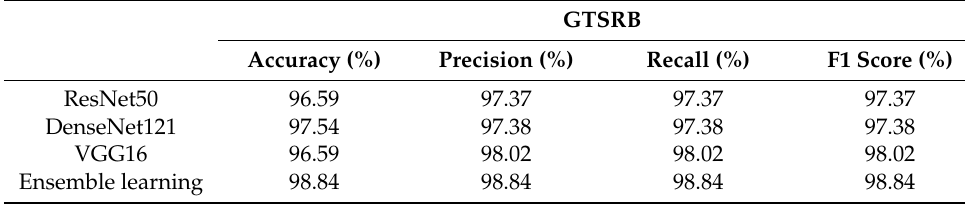
Table 9. Accuracy, precision, recall, and F1 score on GTSRB.